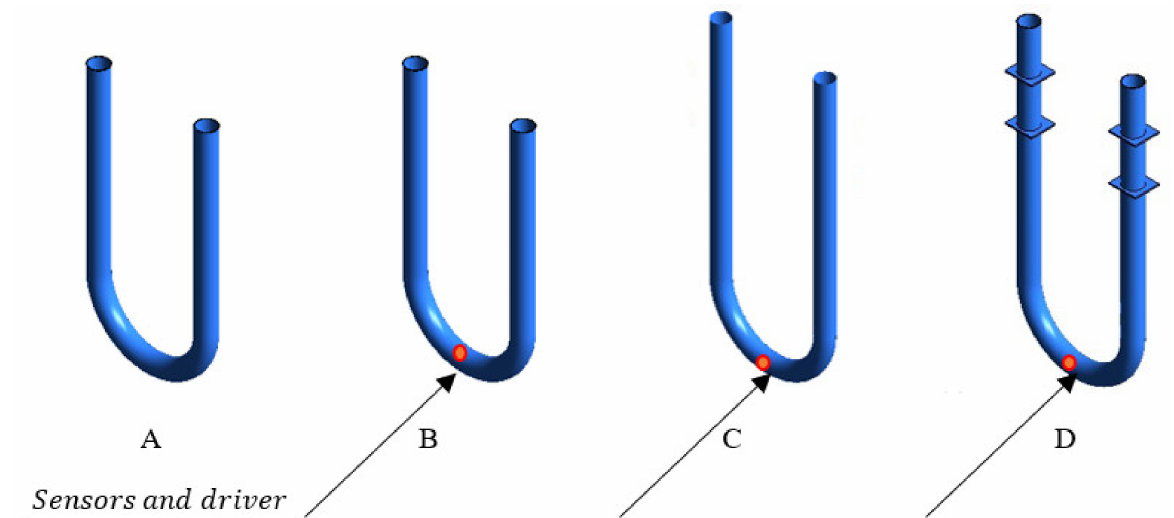
Figure 2. ( A ): equivalent length, the mass of sensors and driver is not considered, with braces not being taken into account; ( B ): equivalent length, the mass of sensors and driver is considered, with braces not being taken into account; ( C ): full length, the mass of sensors and driver is considered, with braces not being taken into account; ( D ): full length, the mass of sensors and driver is considered, with braces being taken into